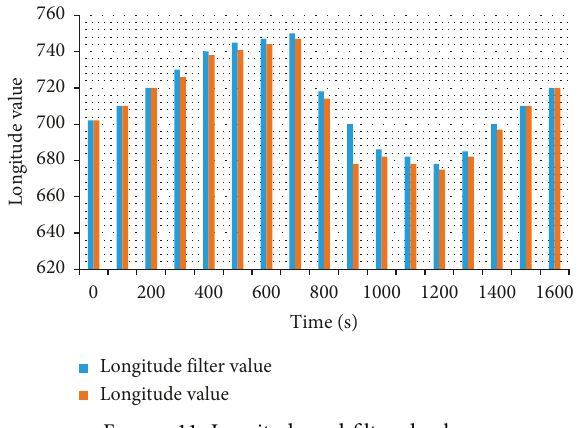
Figure 11: Longitude and filtered